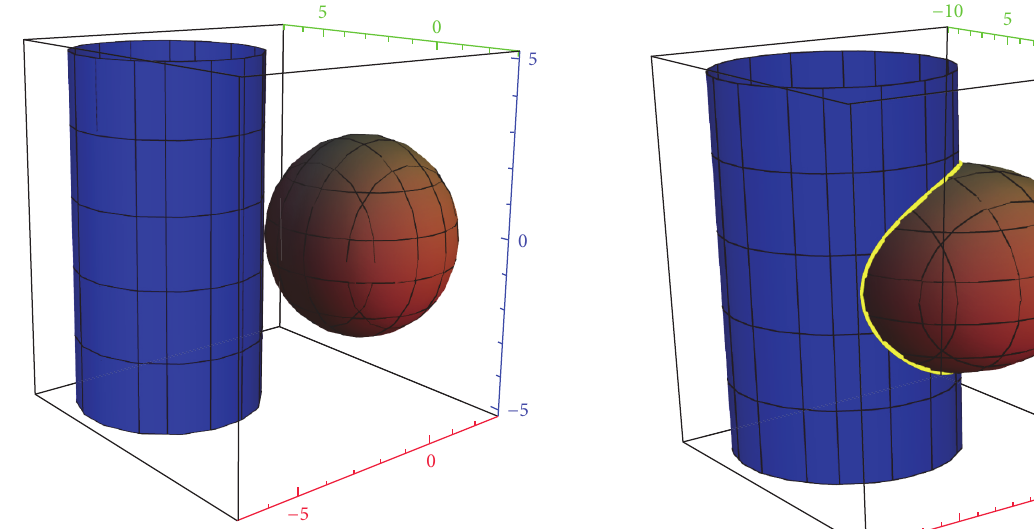
Figure 4: The fiber F (ℎ,𝑐) , (ℎ,𝑐) ∈ Σ 𝑠 2 : a stable equilibrium point.